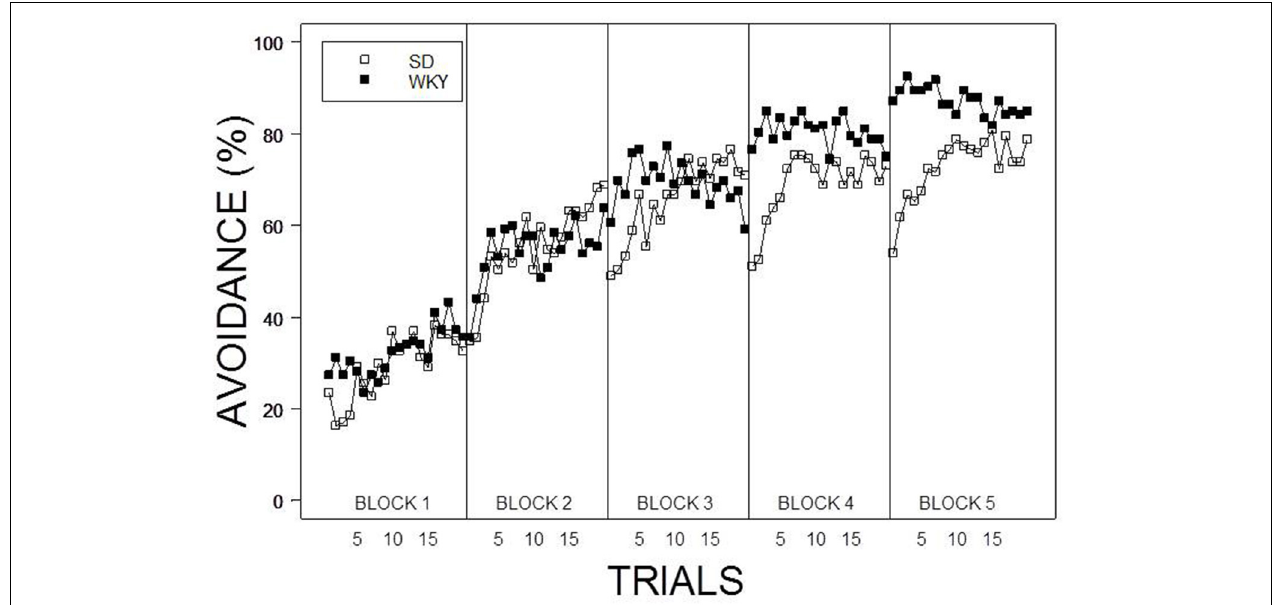
FIGURE 1 | Average percentage of avoidance responses across the 20 trials within each session block. WKY rats acquired lever-press responses faster and to a greater asymptotic degree compared to SD rats regardless of